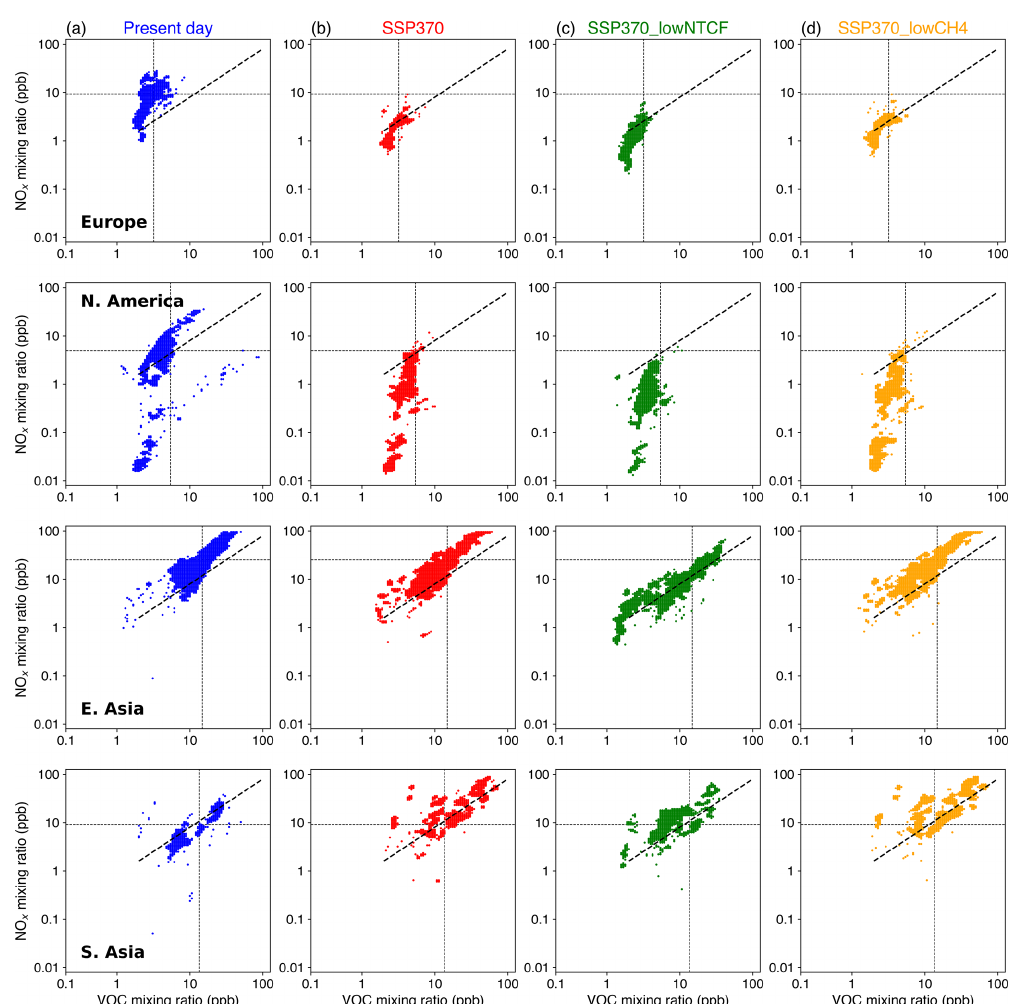
Figure 8. O 3 sensitivity across Europe, North America, East Asia, and South Asia in the present day (a) and under SSP3-7.0 (b) , SSP3-7.0- lowNTCF (c) , and SSP3-7.0-lowCH4 (d) . The NO x / VOC threshold of 0.8 is shown. Horizontal and vertical lines indicate regional mean NO x and VOC mixing ratios in the present